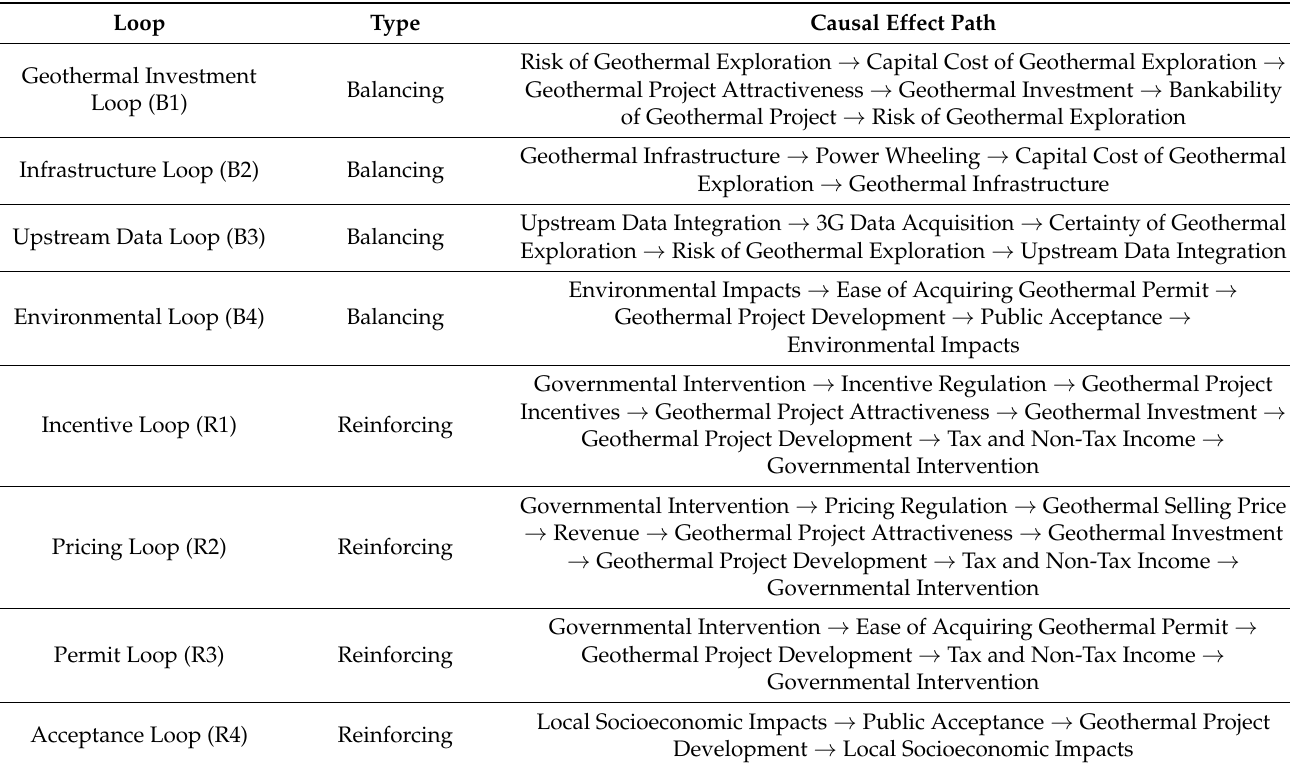
Table 3. Structure of the feedback loops of the conceptual